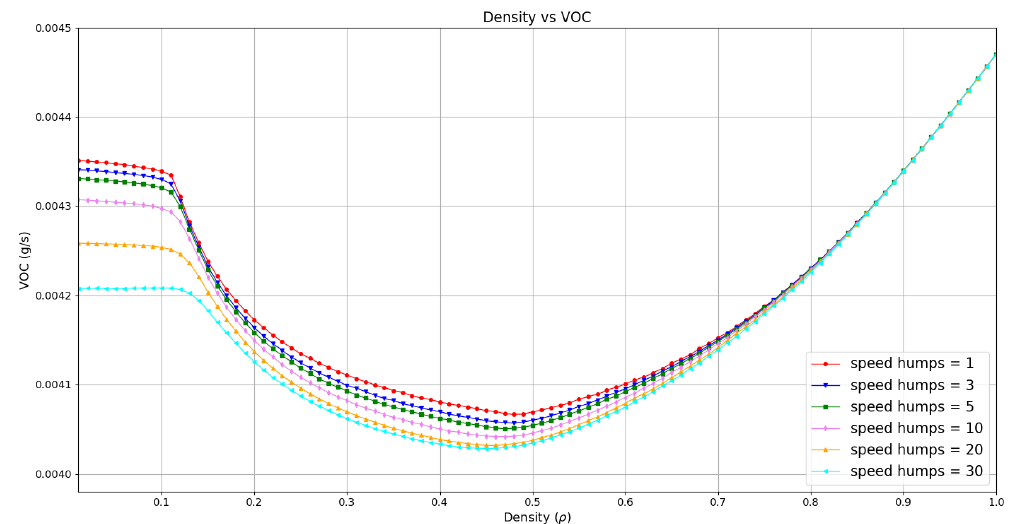
Figure 11. VOC instant emissions as a function of density.